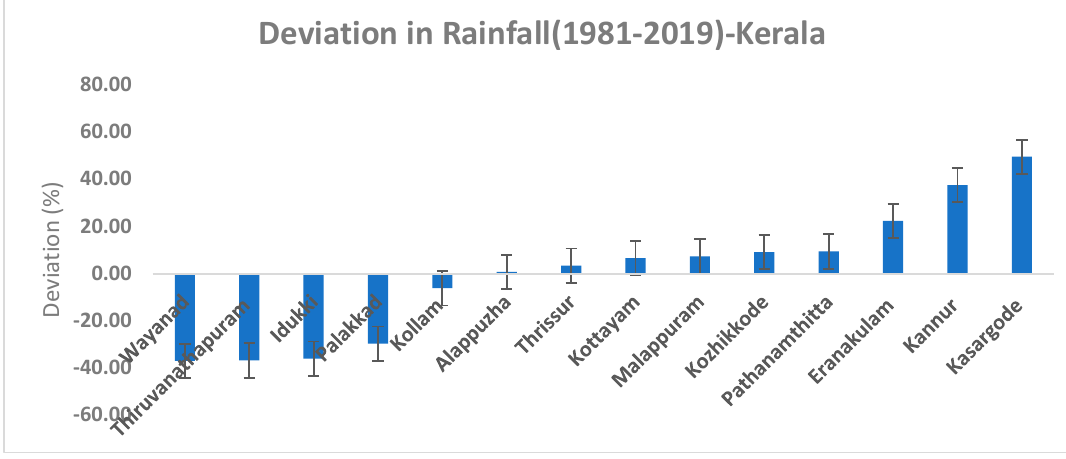
Figure 5. District-wise difference in rainfall distribution from the state’s mean from 1981 to 2019.